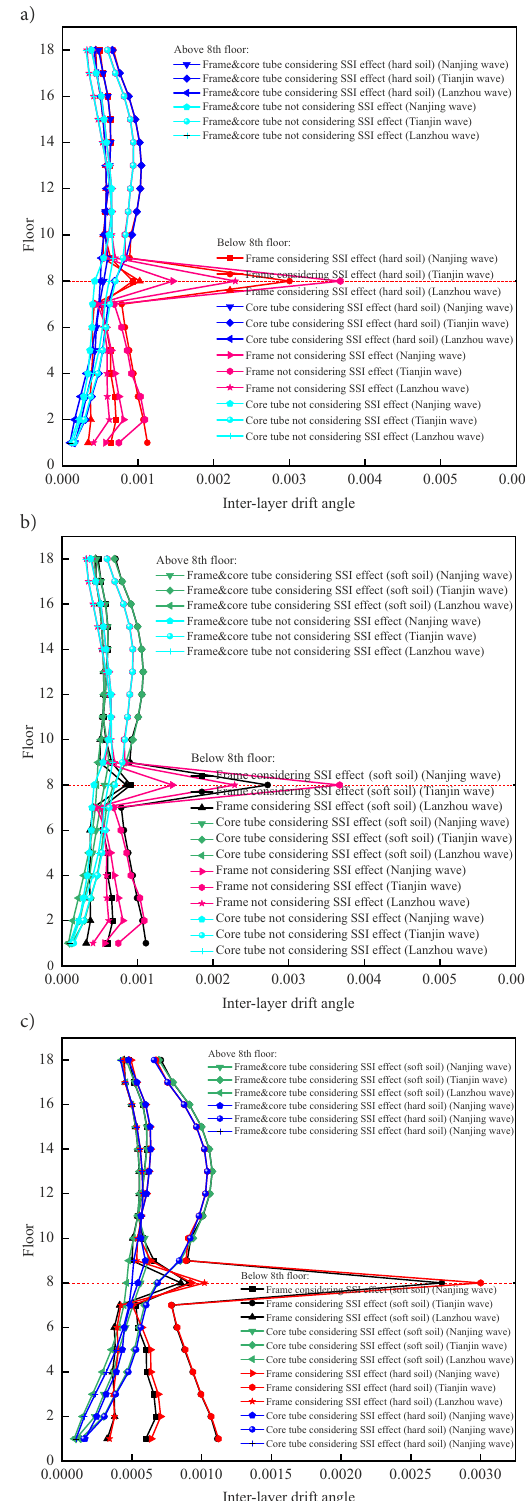
Figure 10. Comparison of inter-layer drift angle: a – comparison of inter-layer drift angle between the new staggered story isolat- ed structure considering SSI effect and not considering SSI effect (hard soil); b – comparison of inter-layer drift angle between the new staggered story isolated structure considering the SSI effect and not considering the SSI effect (soft soil); c – comparison of inter-layer drift angle between different sites soils considering the